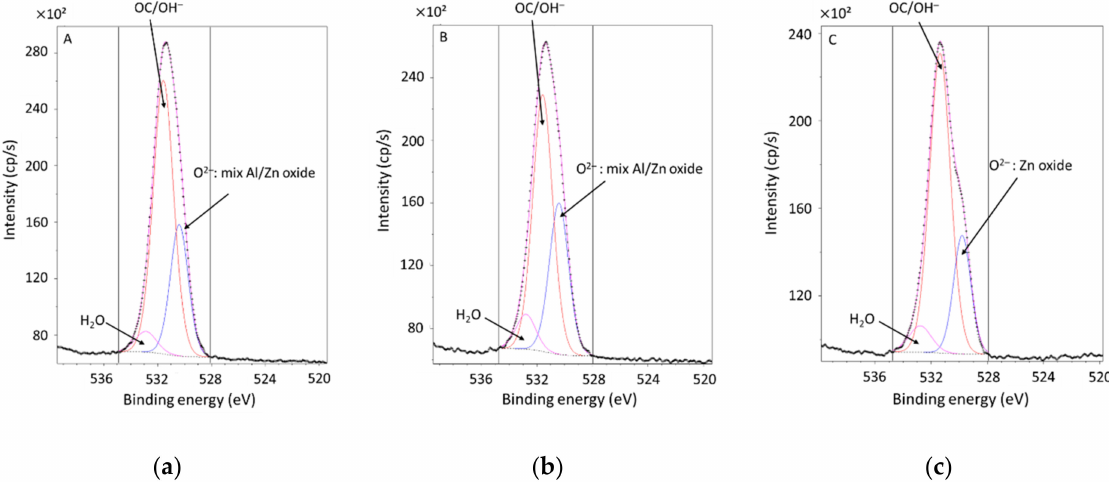
Figure 6. High resolution O1s spectra for bare HDG ( a ) after solvent cleaning, ( b ) after alkaline cleaning at 50 ◦ C during 15 s with an alkaline solution at pH ≈ 10 and ( c ) after alkaline cleaning at 50 ◦ C during 15 s with an alkaline solution at pH >